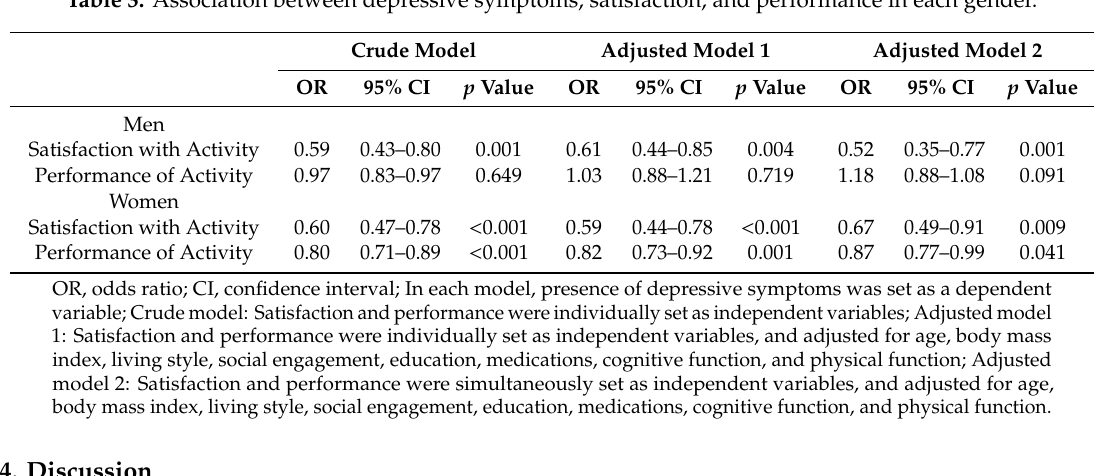
Table 3. Association between depressive symptoms, satisfaction, and performance in each